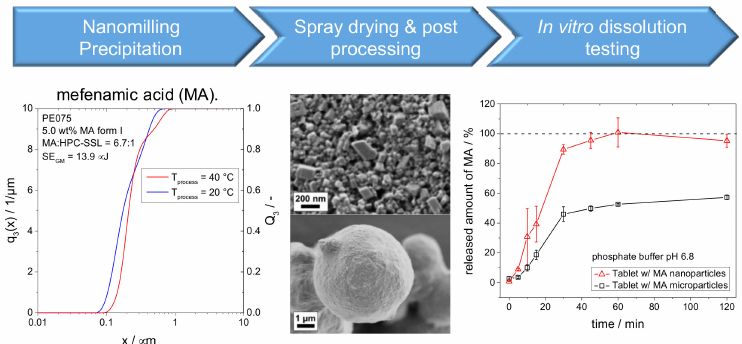
Figure 14. Process chain from nanoparticle formation via spray drying and post processing to in vitro dissolution